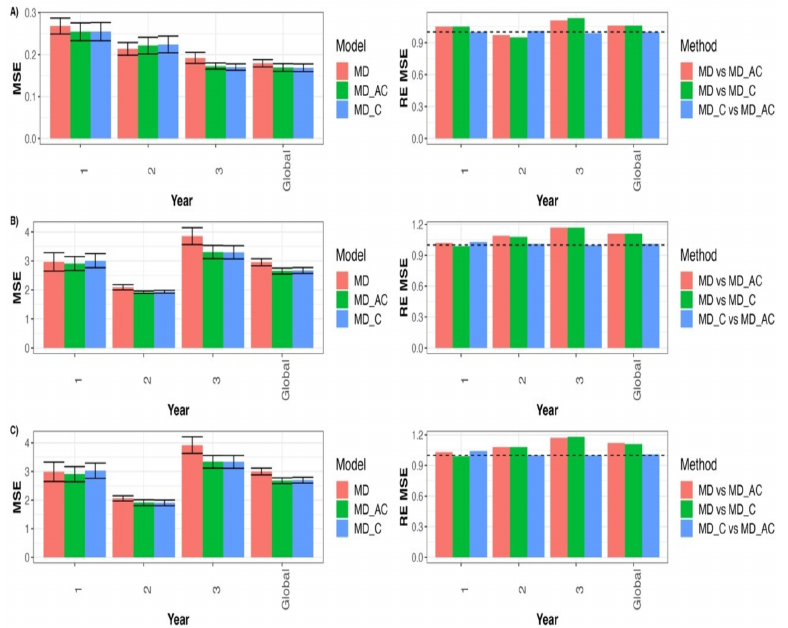
Figure A2. Prediction performance in terms of mean square error (MSE) for models MD, MD_C, and MD_AC for each trait in each environment and across environments (Global) under untested lines in a tested environment cross-validation strategy. The relative efficiencies (RE_MSE) were computed to compare models MD_C to MD_AC, MD to MD_C, and MD to MD_AC. ( A ) for GY trait, ( B ) for DTF trait, and ( C ) for DTH